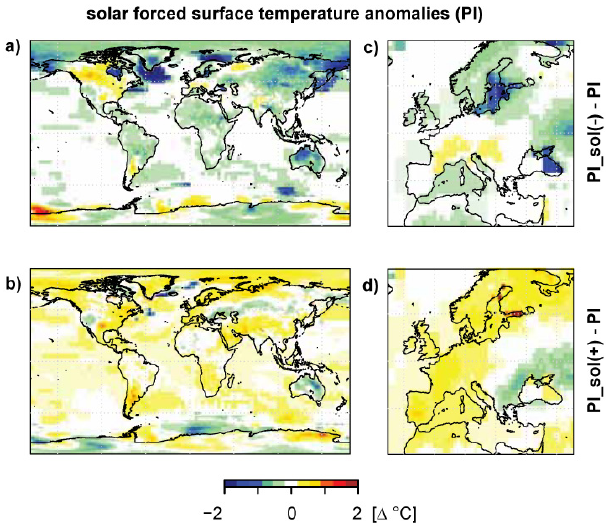
Fig. 4. Simulated solar activity-induced changes of PI surface tem- peratures. The temperature anomalies are calculated between the experiment with additional solar influence boundary conditions (PI sol( − ) and PI sol( + ), respectively) and the undisturbed PI cli- mate simulation. Plot details are similar to Fig.